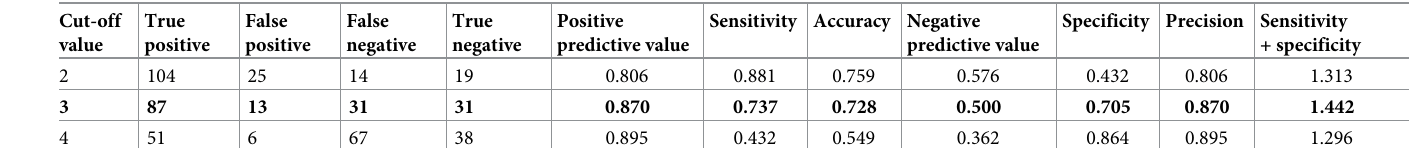
Table 3. Sensitivity and specificity of the Sniff Bubble